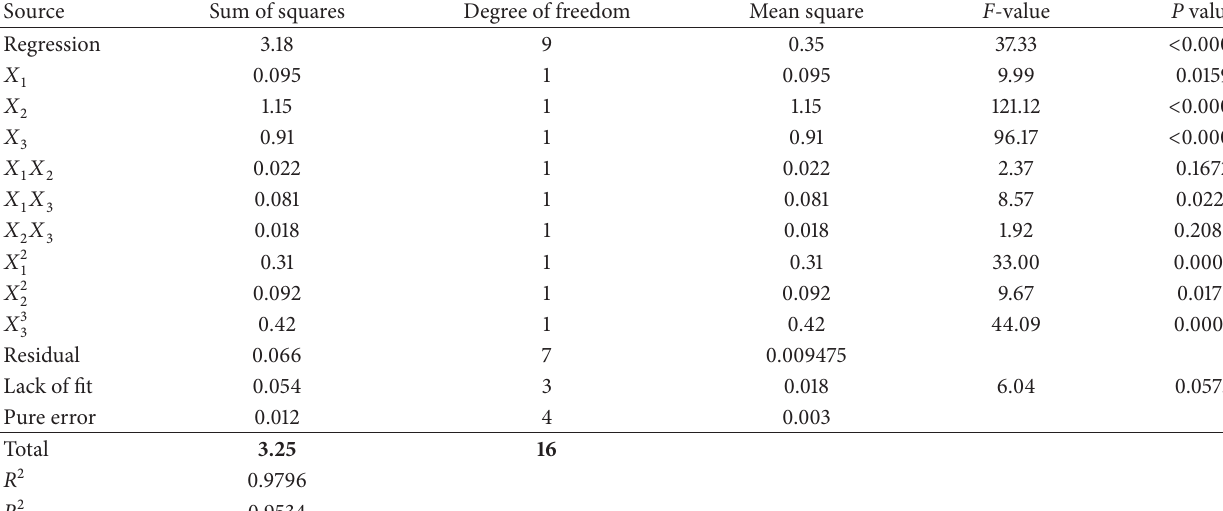
Table 3: ANOVA results for response